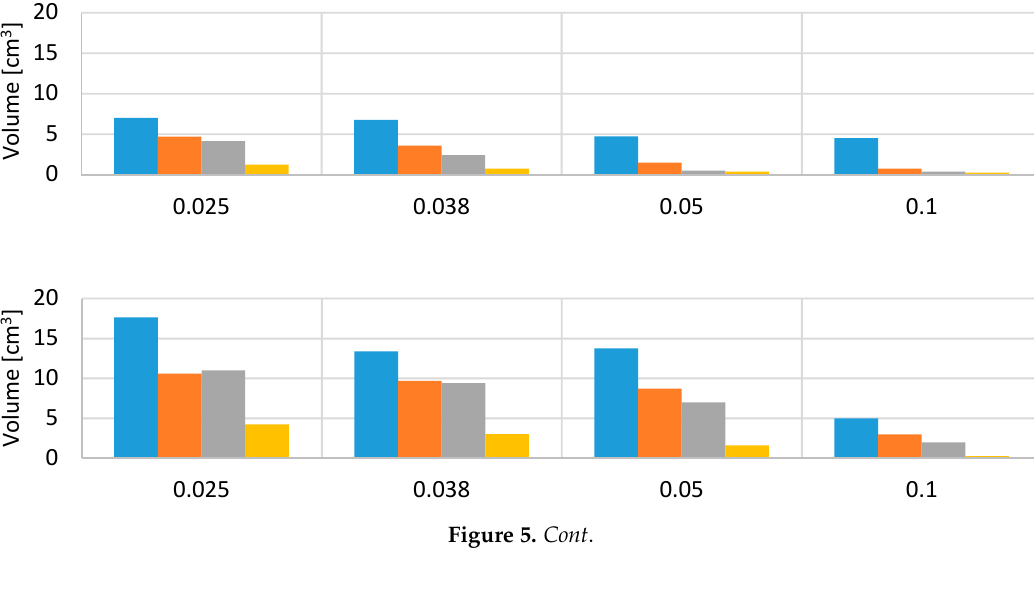
Figure 4. Tool wear for drilling of the TNB alloy (up), ingot TNB (middle), and extruded MoCuSi (down).